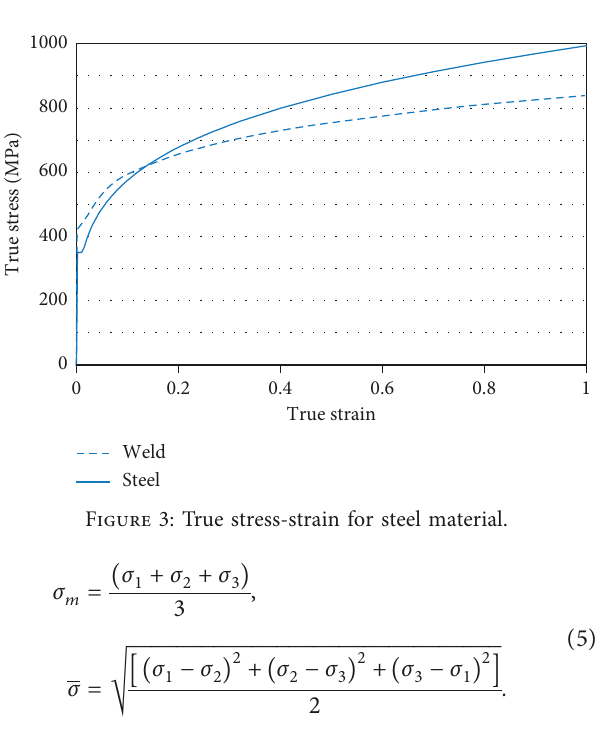
Figure 2: Single- and double-angle tension